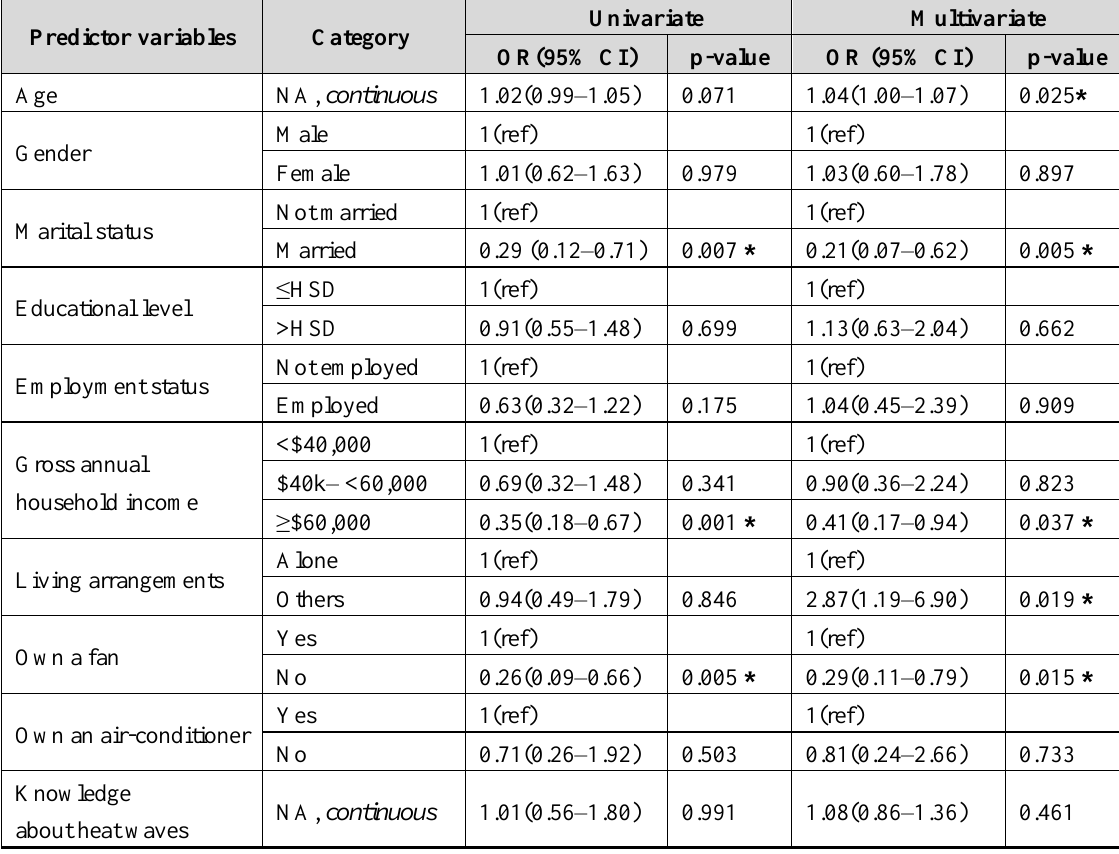
Table 7. Univariate and multiple logistic regression analyses for predictors of risk perception to a heat wave